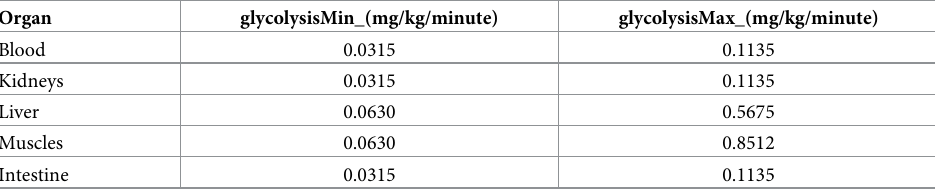
Table 1. The default values for glycolysis related parameters in various